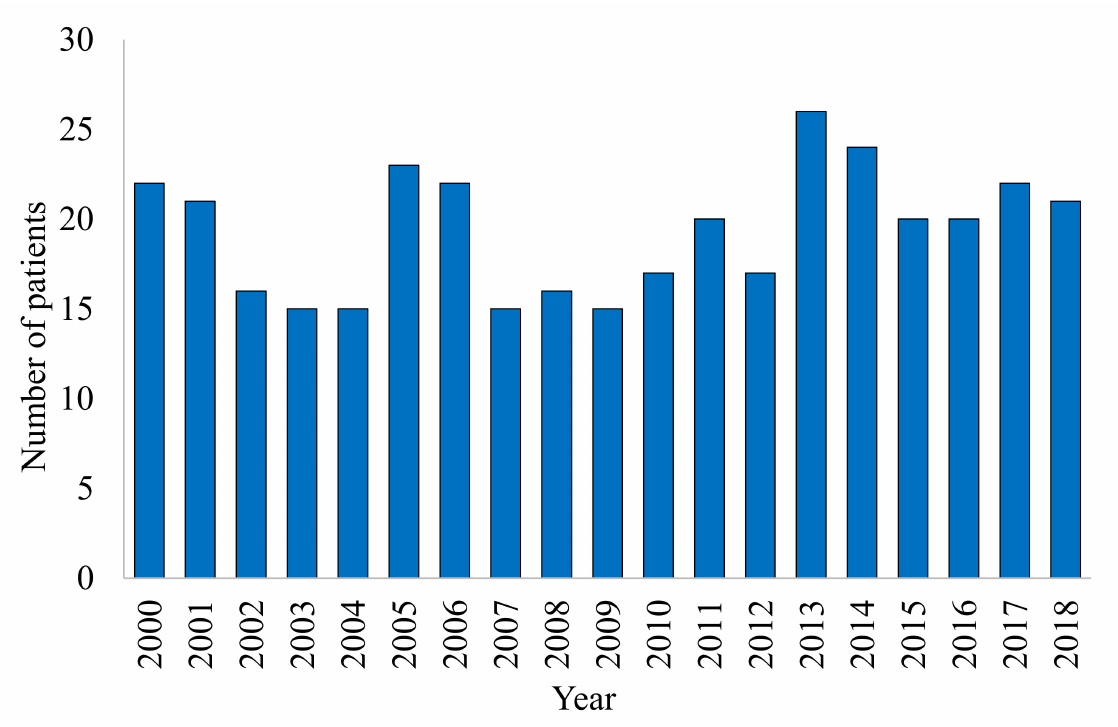
Figure 2. The number of deaths of patients with CF in the 2000–2018